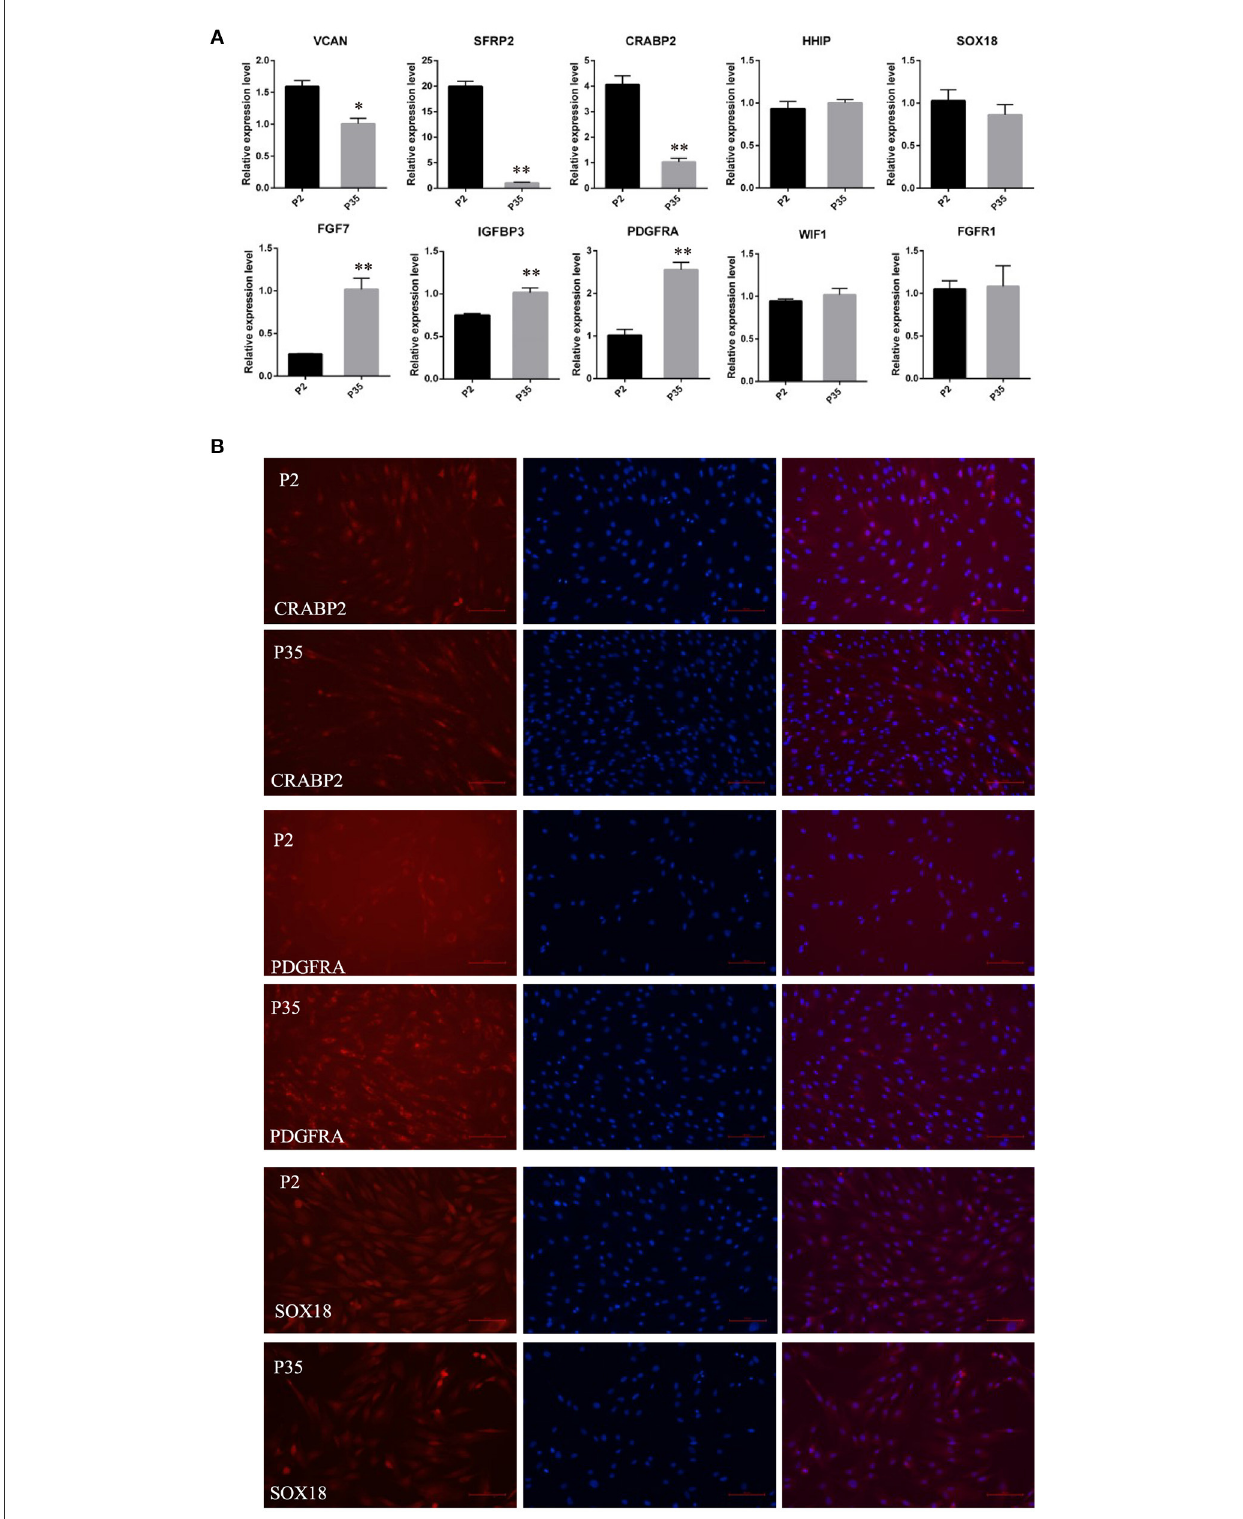
FIGURE3 The expression changes of marker genes of DPCs during a period of culture ex vivo . (A) qRT-PCR of marker genes of ovine DPCs in passage 2 and passage 35. (B) Immunofluorescence staining of CRABP2, PDGFRA and SOX18 in early passaged ovine DPCs and multiple passaged DPCs. The expression of specific gene was quantified relative to the expression level of GAPDH using the comparative cycle threshold ( 11 CT) method. The data were expressed as the mean ± SE ( n = 3). * P < 0.05, ** P < 0.01. Red fluorescence indicated the expression pattern of the interested protein. Nucleus was stained with Hoechst in blue. Scale bars, 100 µ